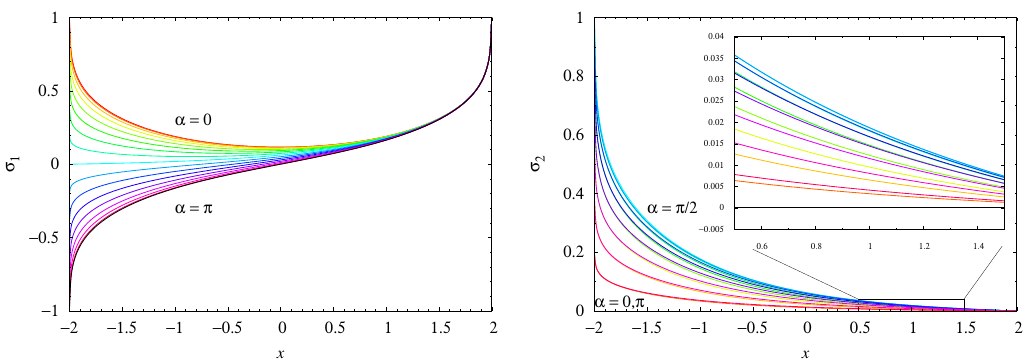
Figure 2. The functions (cid:27) 1 ( x ) (left) and (cid:27) 2 ( x ) (right) which are the solutions to the gap equation, eq. (3.1), for various values of (cid:11) for L = 4 and (cid:3) = 1. (cid:11) = 0 ; (cid:25) bottom curves for (cid:27) 1 on the left. The curves for (cid:27) 2 ( x ) on the right read from the bottom ( (cid:27) 2 (cid:17) 0 for (cid:11) = 0) to the top curve at (cid:11) = (cid:25)= 2, and then back towards the bottom ( (cid:27) 2 (cid:17) 0 again for (cid:11) = (cid:25) ). The colors are shown in the legend of (cid:12)gure